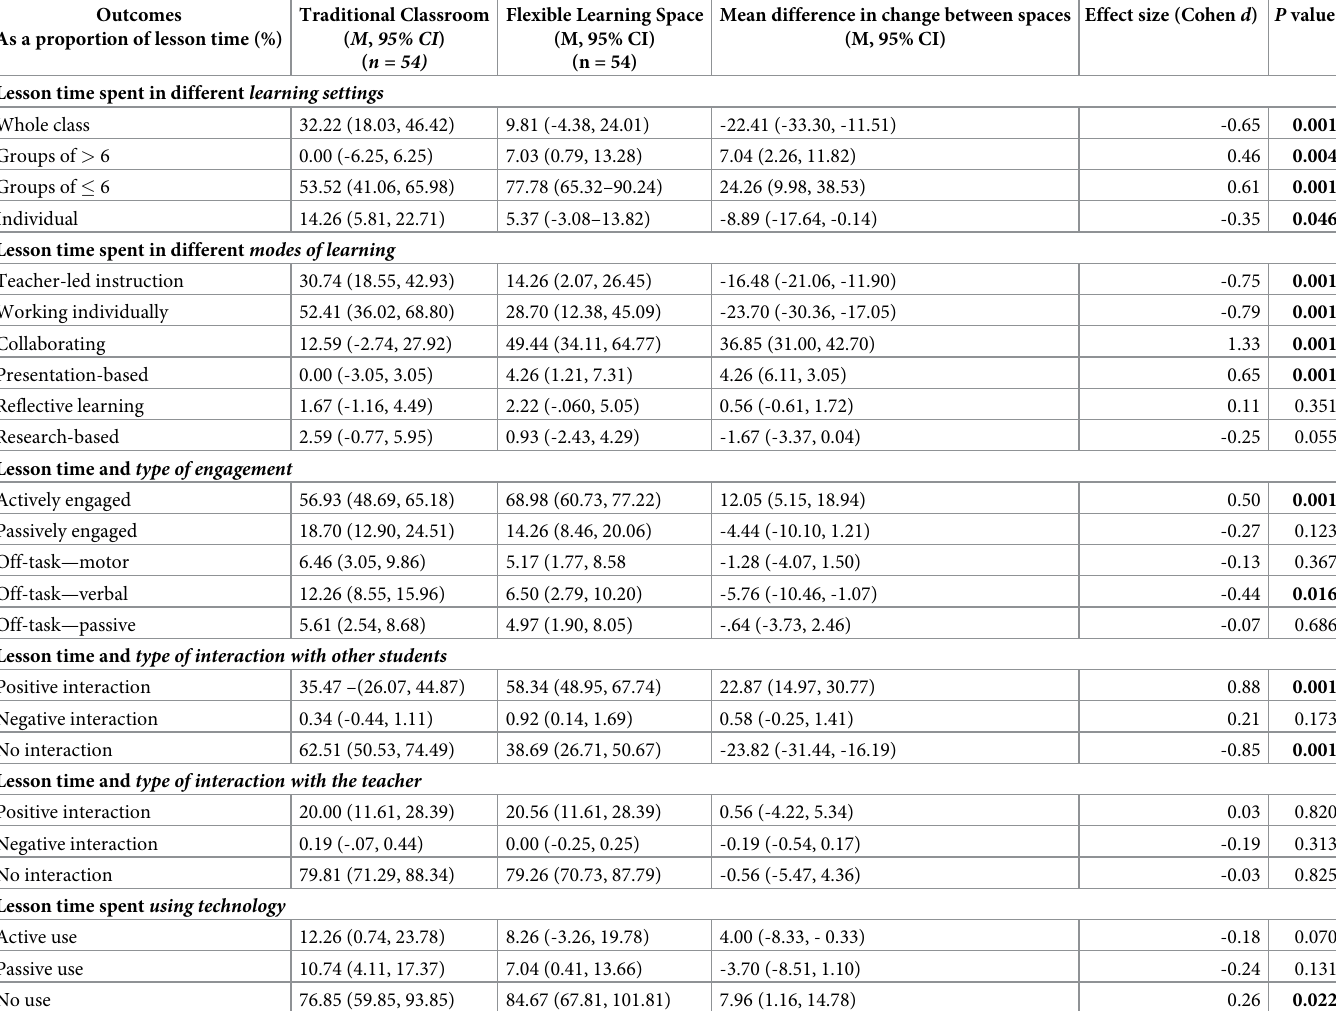
Table 3. Difference in lesson time students spent engaged in outcome variables between the traditional classrooms and flexible learning space. Outcomes Traditional Classroom As a proportion of lesson time (%) ( M , 95% CI